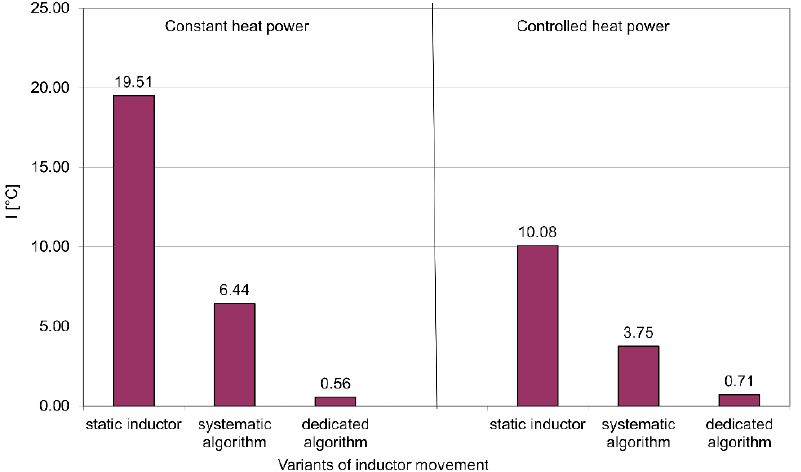
Figure 16. Values of indicator I calculated for different variants of inductor displacement and power supply.